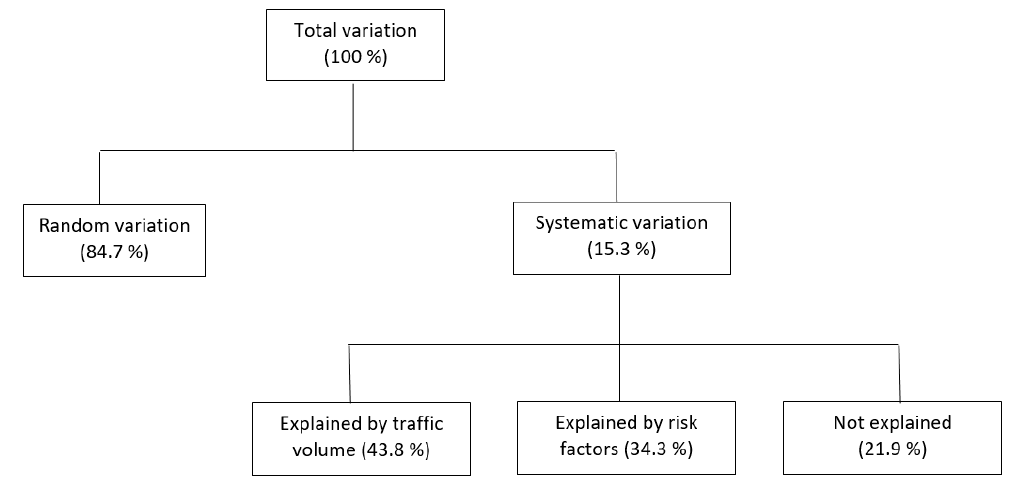
Figure 1 Decomposing sources of variation in the number of accidents in horizontal curves on rural two-lane roads in